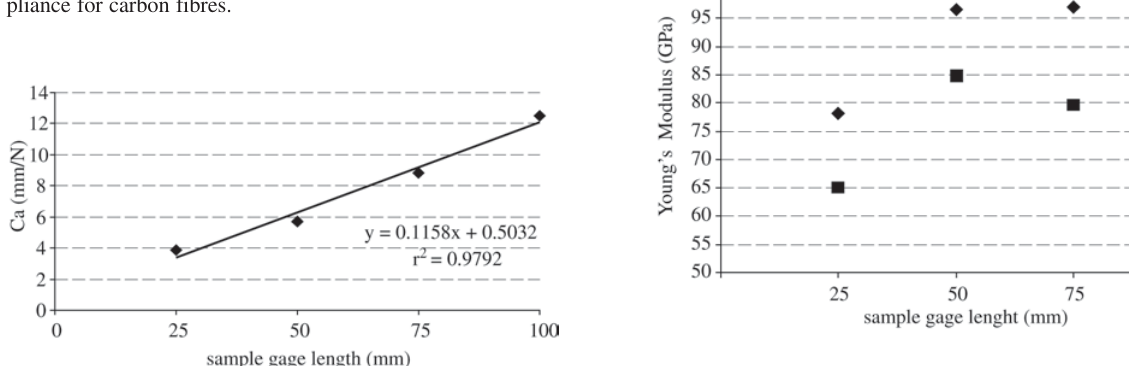
Figure 9. Young’s modulus for glass fibres. (u) assuming ideal Hookean behaviour, (g) corrected Young’s modulus according to ASTM D